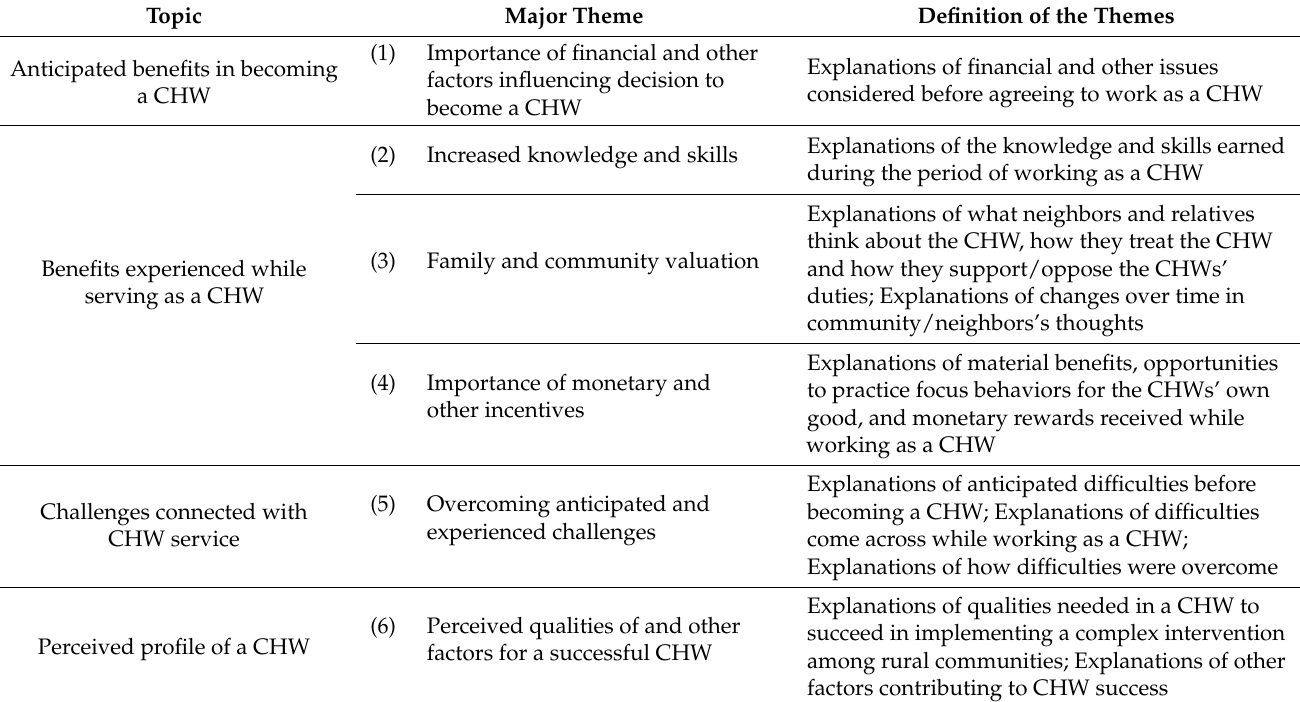
Table 3. Themes from the thematic analysis of the interviews and focus groups conducted with female CHWs.